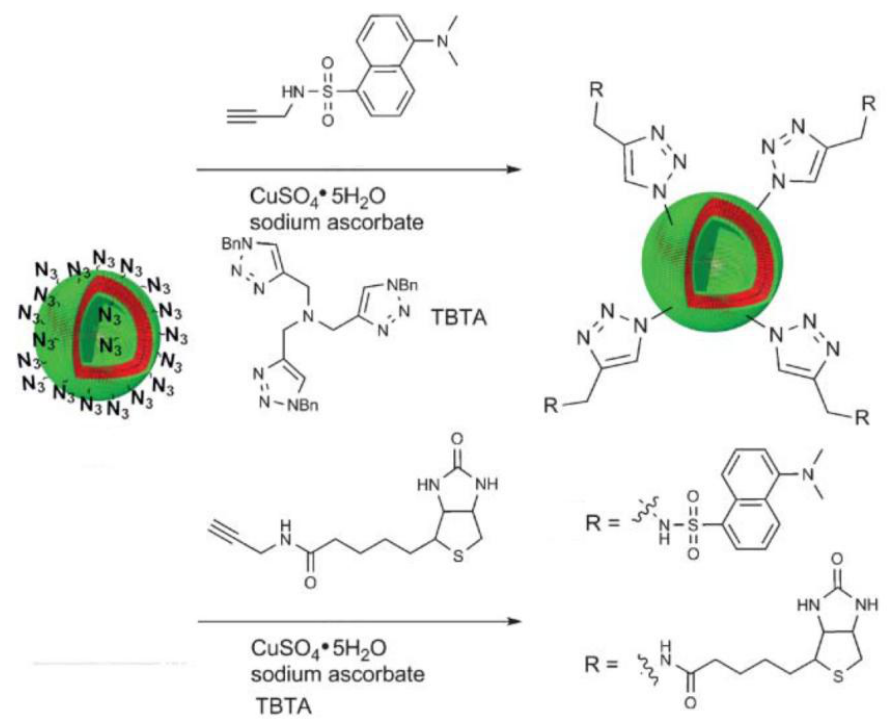
Figure 4. Modification of the outer polymersome surface by click chemistry. Alkyne bearing fluorescent dansyl probe and biotin were attached to azide functionalized polymersomes. Reproduced by permission of the Royal Society of Chemistry